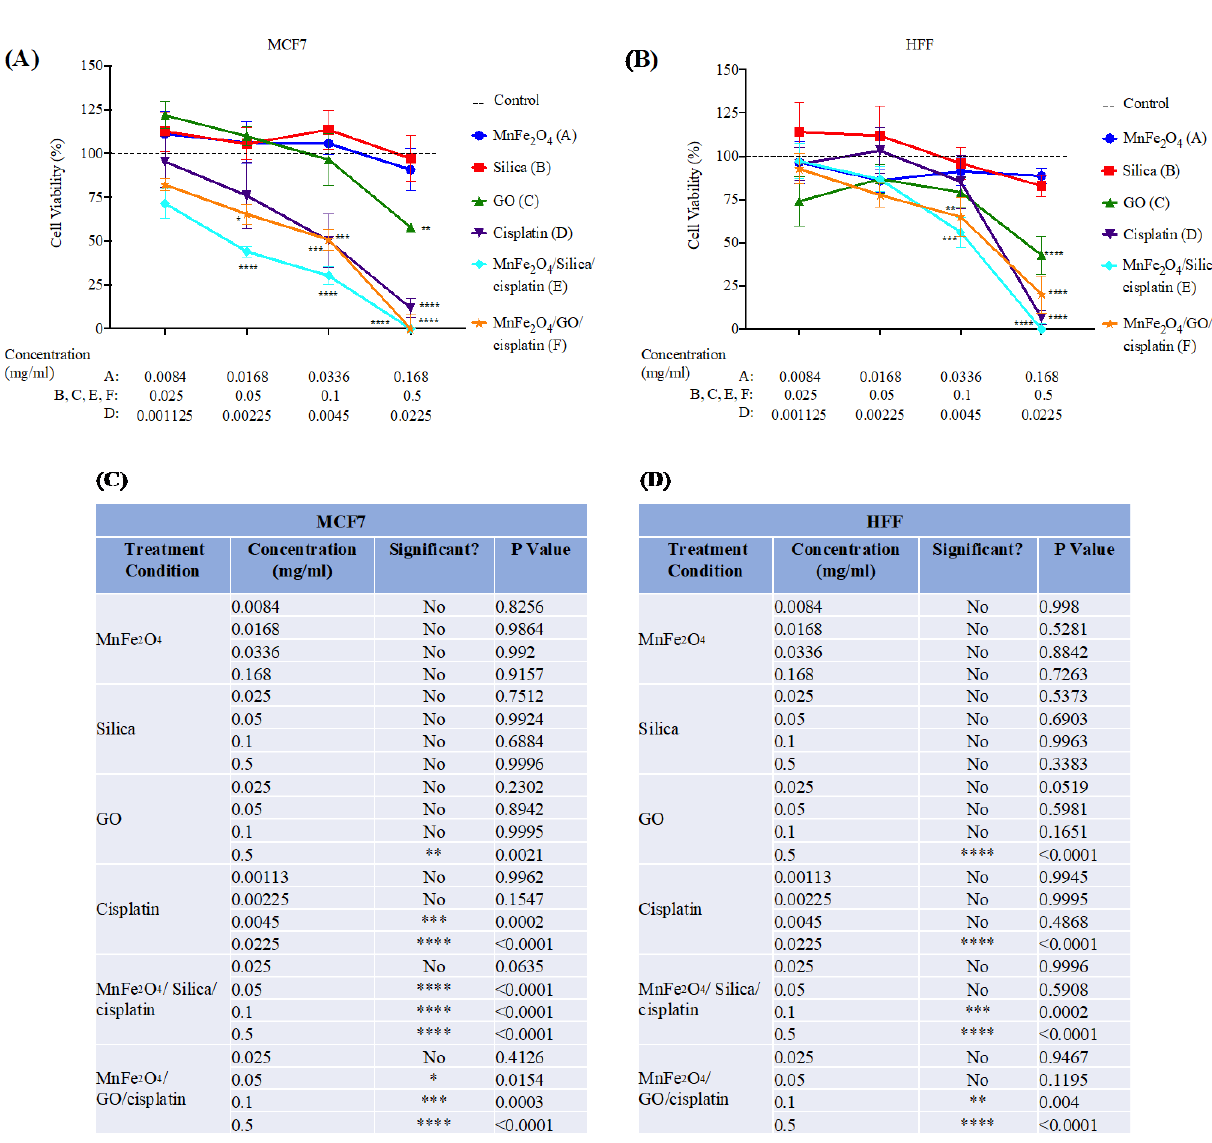
Figure 7. MTT cell viability assay on: ( A ) MCF7; and ( B ) HFF cell lines. Cells were treated with the following conditions for 48 h: MnFe 2 O 4 , silica, GO, Cisplatin, Cisplatin/silica/MnFe 2 O 4 and Cisplatin/GO/MnFe 2 O 4 ; ( C , D ) treatment concentrations and statistical analysis for MCF7 ( C ); and HFF ( D ). Different treatment concentrations were used for MnFe 2 O 4 and cisplatin to reflect the actual concentration adsorbed on the nanocomposite. For details, please see the Materials and Methods section. N = 4 independent experiments. Dashed line represents untreated cells, control. * p < 0.05; ** p < 0.01; *** p < 0.001; **** p < 0.0001 versus control using two-way ANOVA with Dunnett’s post